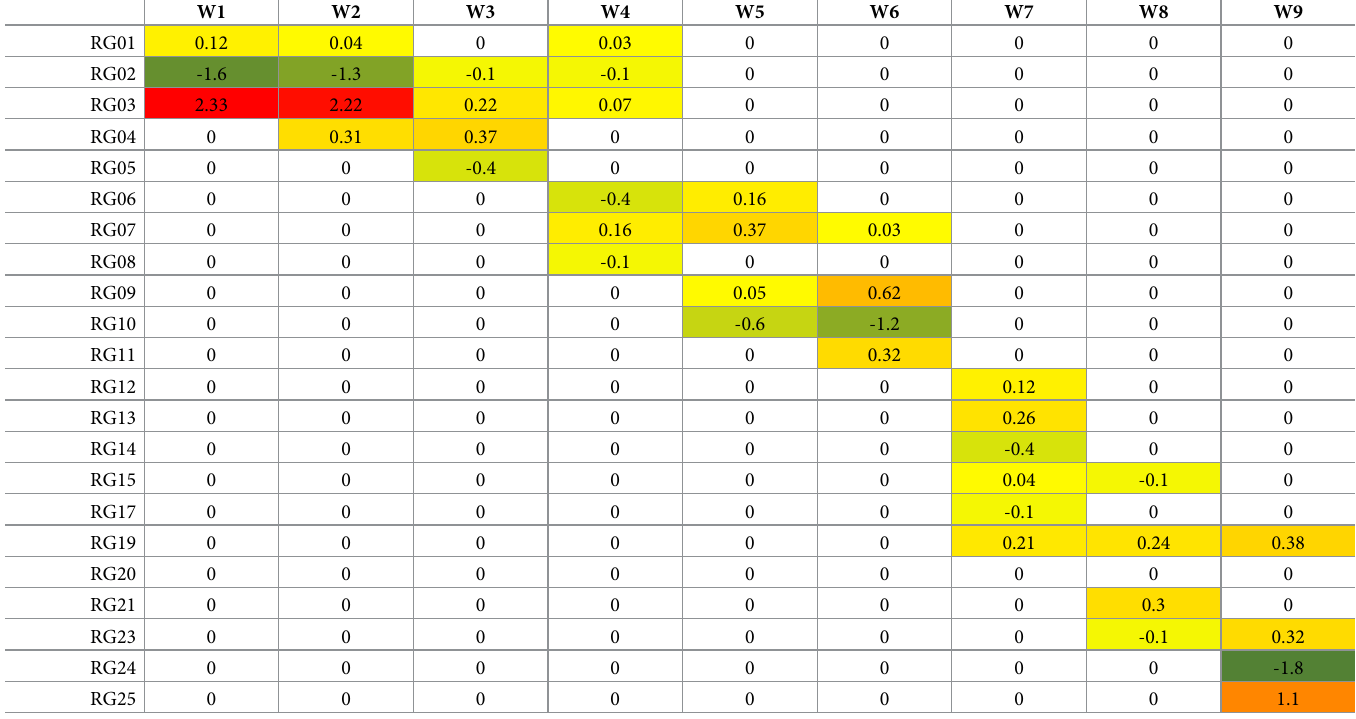
Table 2. Percent change in aerially weighted precipitation estimates by catchment (W1 to W9) incurred by removing one gauge at a time, using IDW for spatial interpolation among